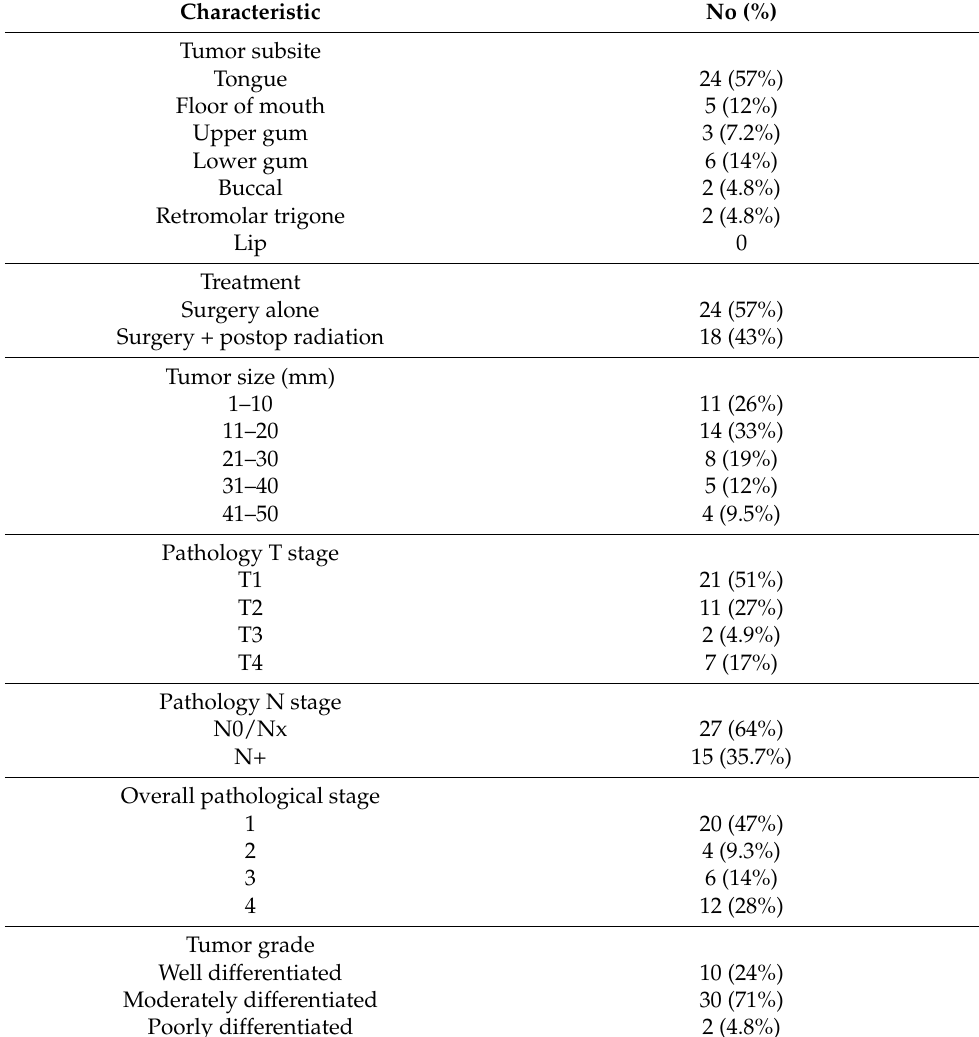
Table 2. Pathology characteristics of OC-SCC